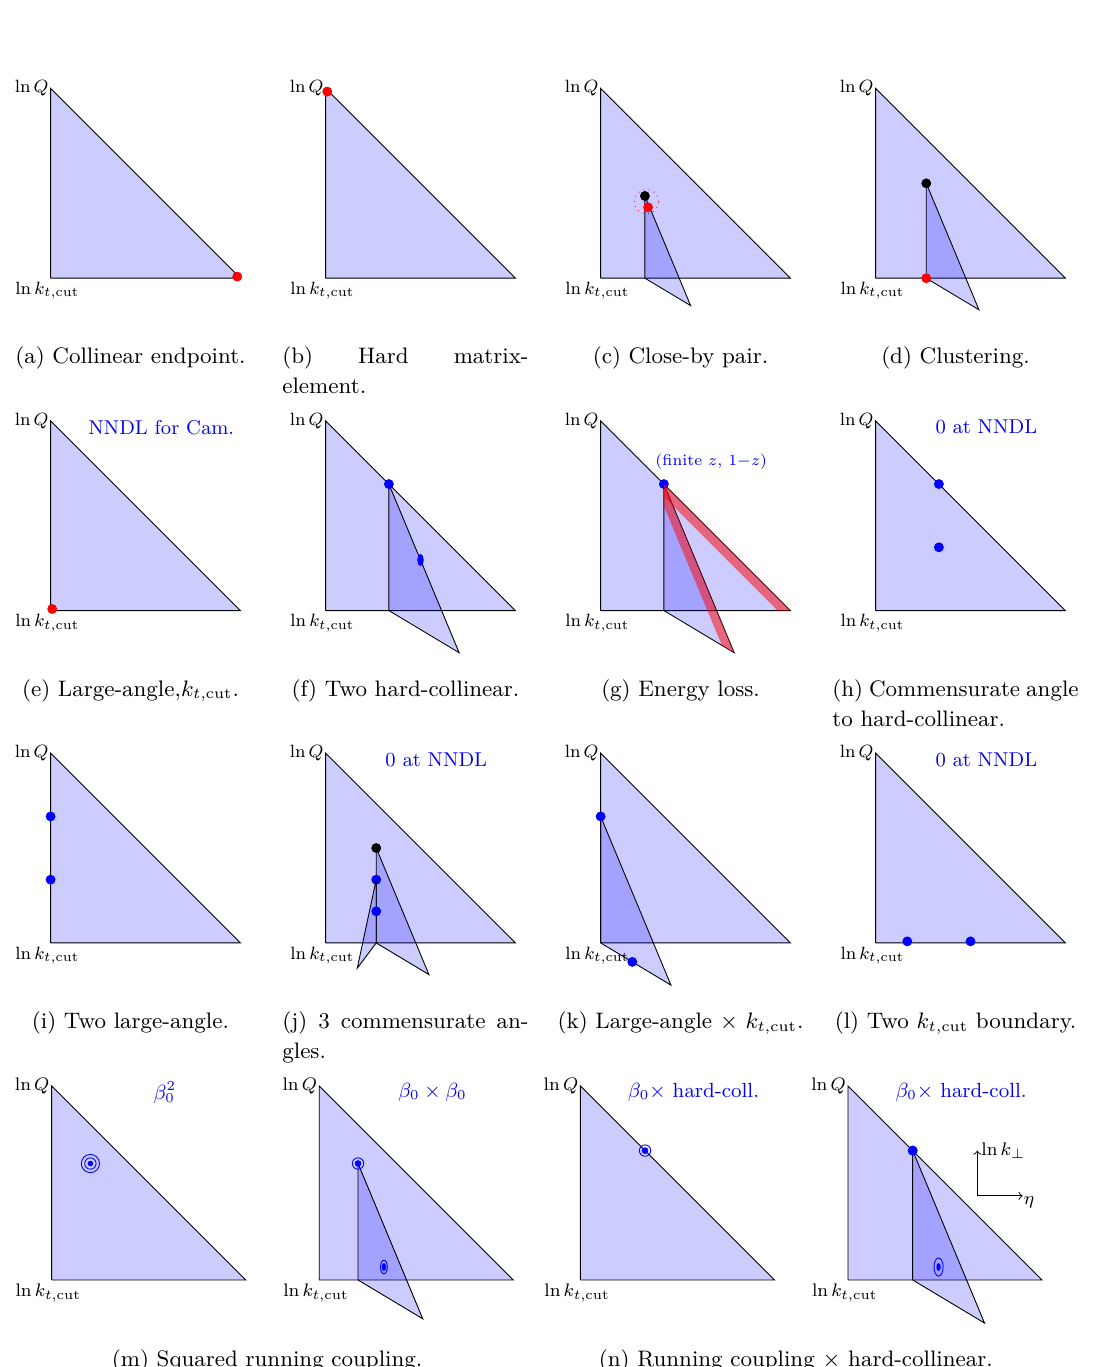
Figure 4. Lund representation of the configurations that contribute to the multiplicity at NNDL. Black dots indicate soft-collinear emissions ( ∝ α 2 ), blue dots emissions which contribute a factor s L α s L , and red dots emissions which only contribute a factor α s with no logarithmic enhancement. Running-coupling corrections ( ∝ α ) are represented by open s L